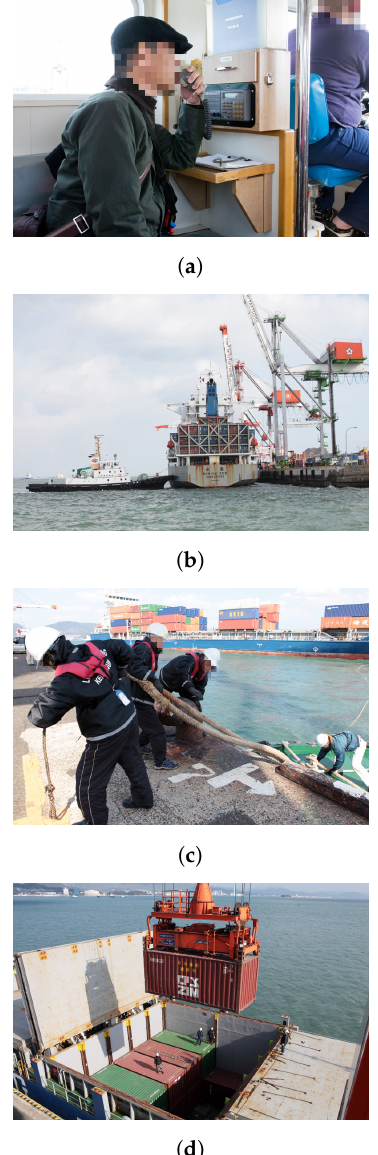
Figure 1. Berthing operations for large vessels [1]: ( a ) guiding of the vessel by the pilot; ( b ) pushing of the vessel by tugboat to approach the wharf side; ( c ) mooring of the vessel by the wharf-side staff; ( d ) removing of the containers from the